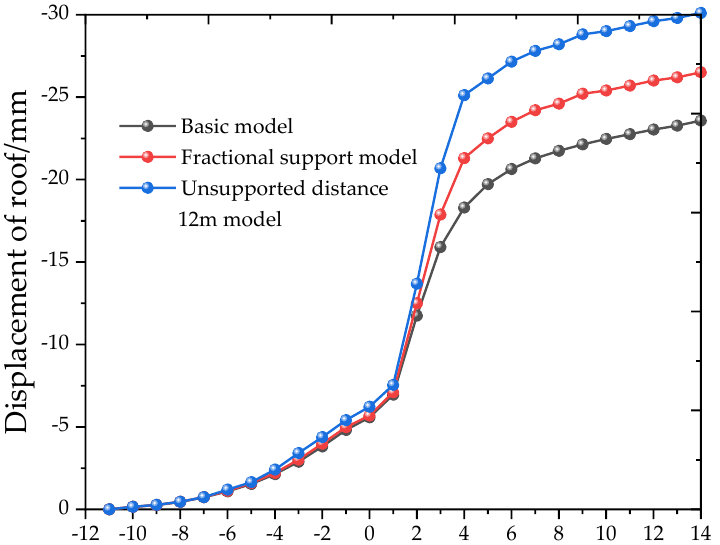
Figure 12. Curve between roadway roof displacement and distance to heading face.